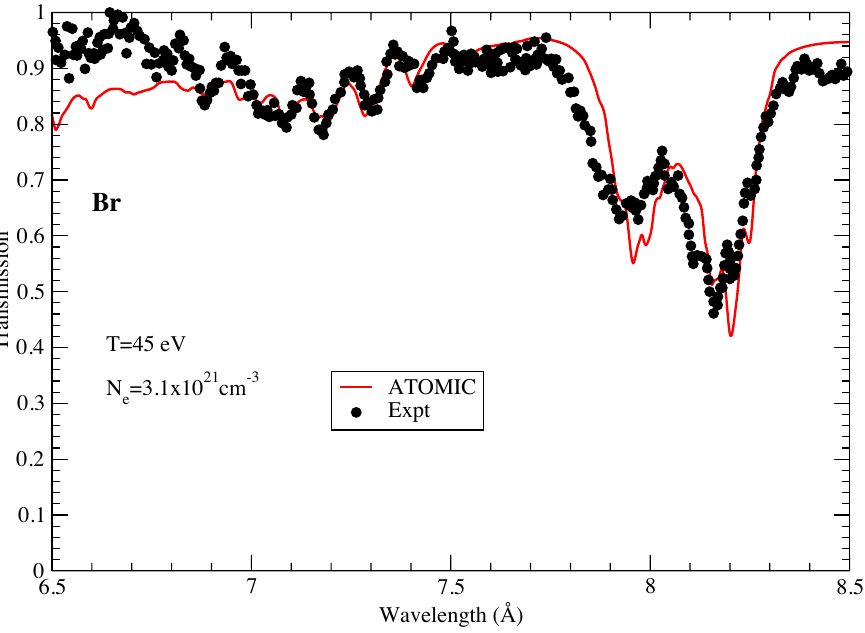
Figure 4. The transmission of Br as measured by [32]. The experimental data are compared with ATOMIC calculations at a temperature of 45 eV and an electron density of 3.1 × 10 21 cm − 3